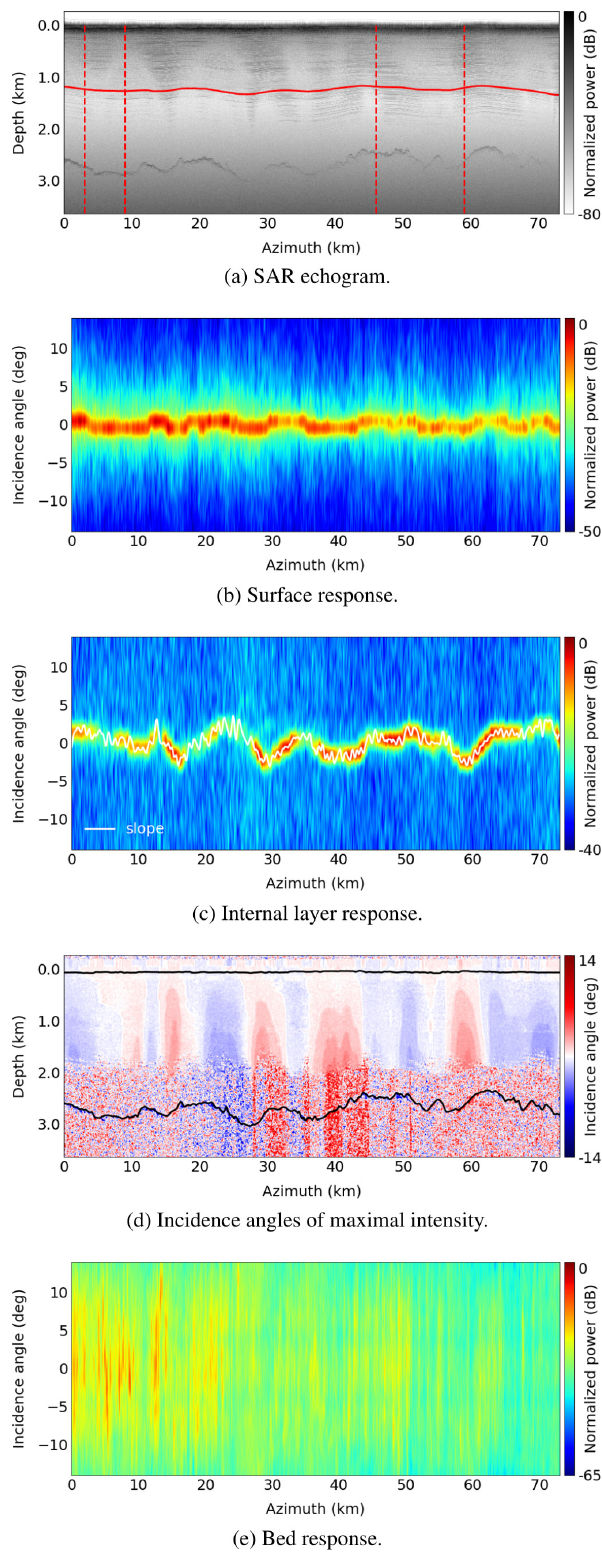
Figure 3. Backscattering characteristics of the ice sheet and bed for track